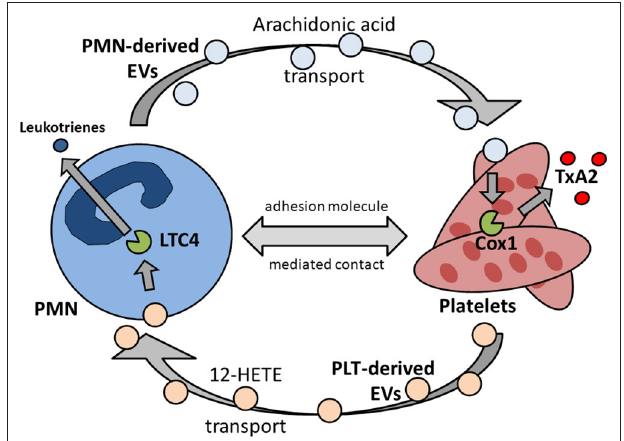
FIGURE 2 | Reciprocal transcellular exchange of substrate and metabolites by extracellular vesicles governs synthesis and release of pro-inflammatory mediators. PMN, polymorphonuclear granulocyte, neutrophil; EV, extracellular vesicles; Cox1, cyclooxygenase 1; TxA 2 , thromboxane A 2 ; PLT, platelet; 12-HETE, 12-hydroxyeicosatetenoic acid; LTC4, leukotriene 4